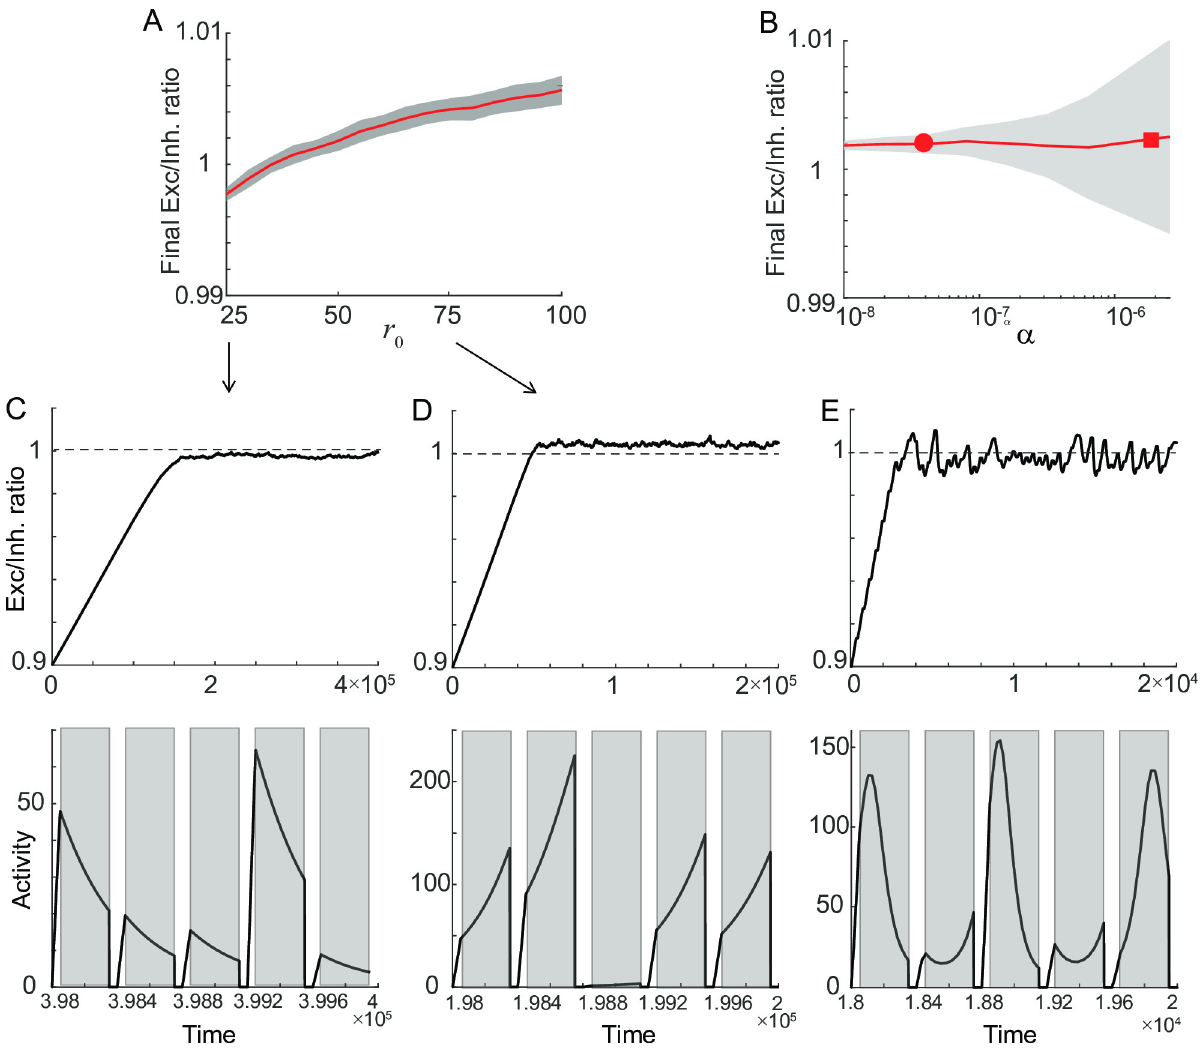
Fig 4. Sensitivity of homeostatic learning rule on learning parameters. A-B: Dependence of final balance ratio W exc / W inh on r 0 (A) and α (B). After reaching the steady state, W / W was averaged over the trials whose mean and standard deviation were shown as red curve and graded area. C-D: exc inh Evolution of W / W over trials (top) and the activity after reaching the steady state (bottom) for lower r exc inh Fig 3B and 3C. E: Sensitivity to learning speed α . For a faster learning rate, the homeostatic plasticity leads to the oscillation even for properly tuned r 0 , leading to a larger standard deviation (square in B) compared to a slower learning rate (circle in B corresponding to Fig 3B and 3C).